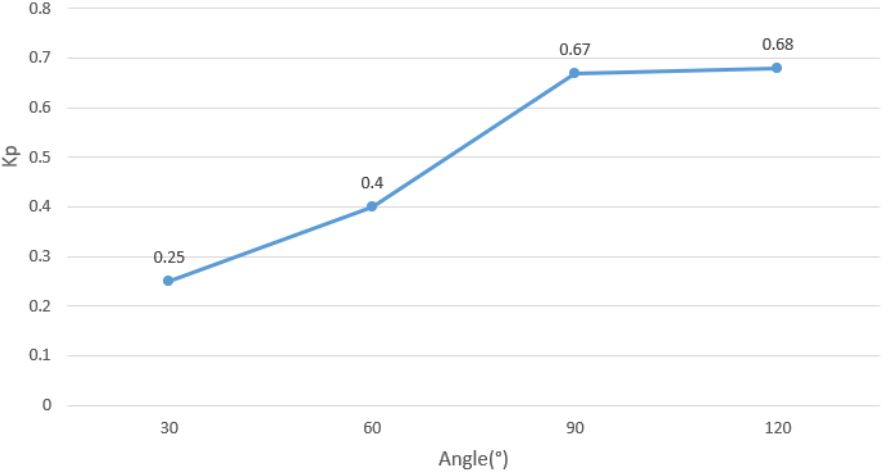
Figure 22. Simulation parameters at different angles.